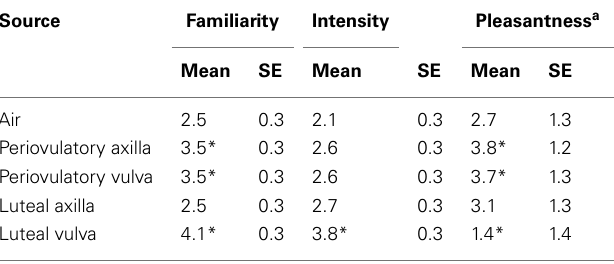
Table 1 | Hedonic ratings given to air and female odors